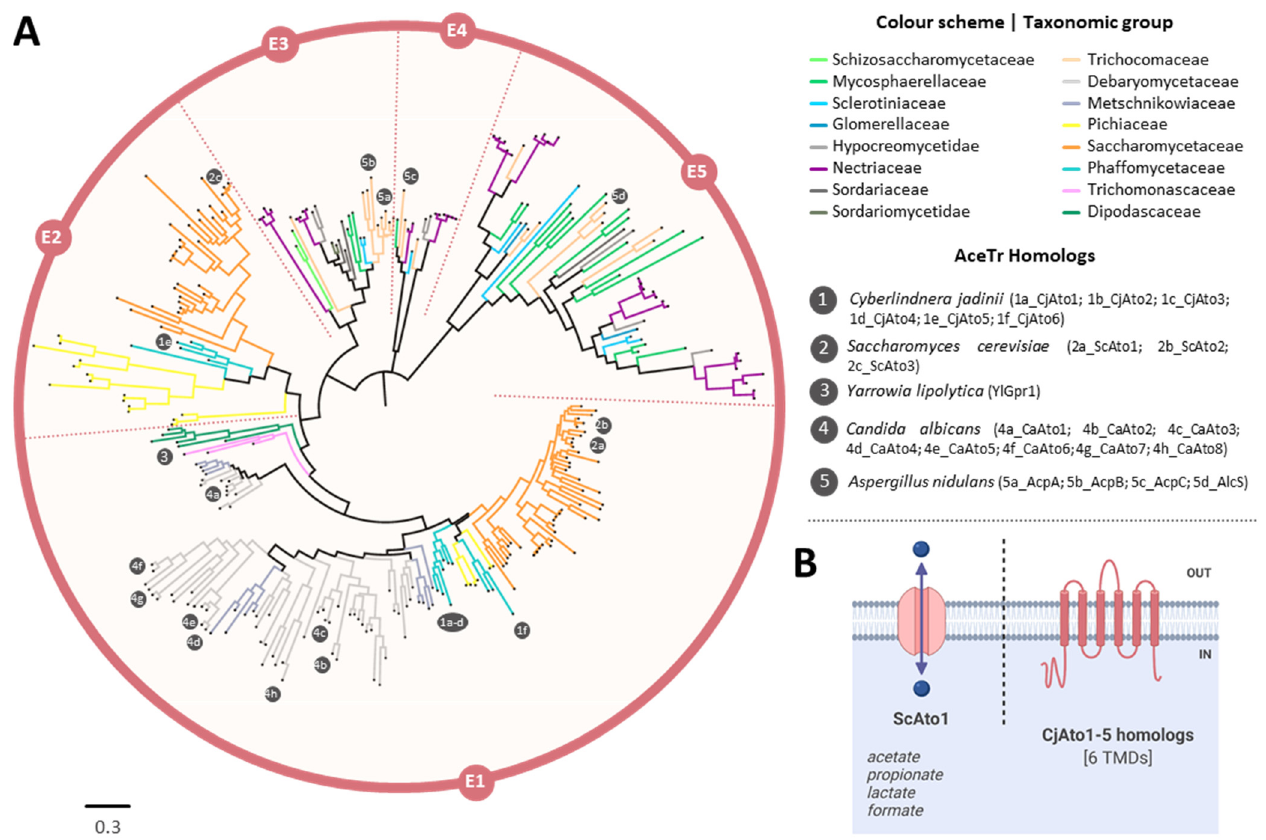
Figure 7. Maximum likelihood phylogenetic tree of AceTr family members (TCDB 2.A.96) present in ascomycetes. ( A ) Branch lengths are proportional to sequence divergence, and different colors correspond to the different families. The clades indicated as E1, E2, E3, E4, and E5 were created to facilitate the tree description in the main text and are not meant to provide any type of classification. Homologs relevant for the discussion through the manuscript are highlighted. ( B ) A simplified scheme of Ato1 native and CjAto proteins with inferred substrate specificities is depicted.